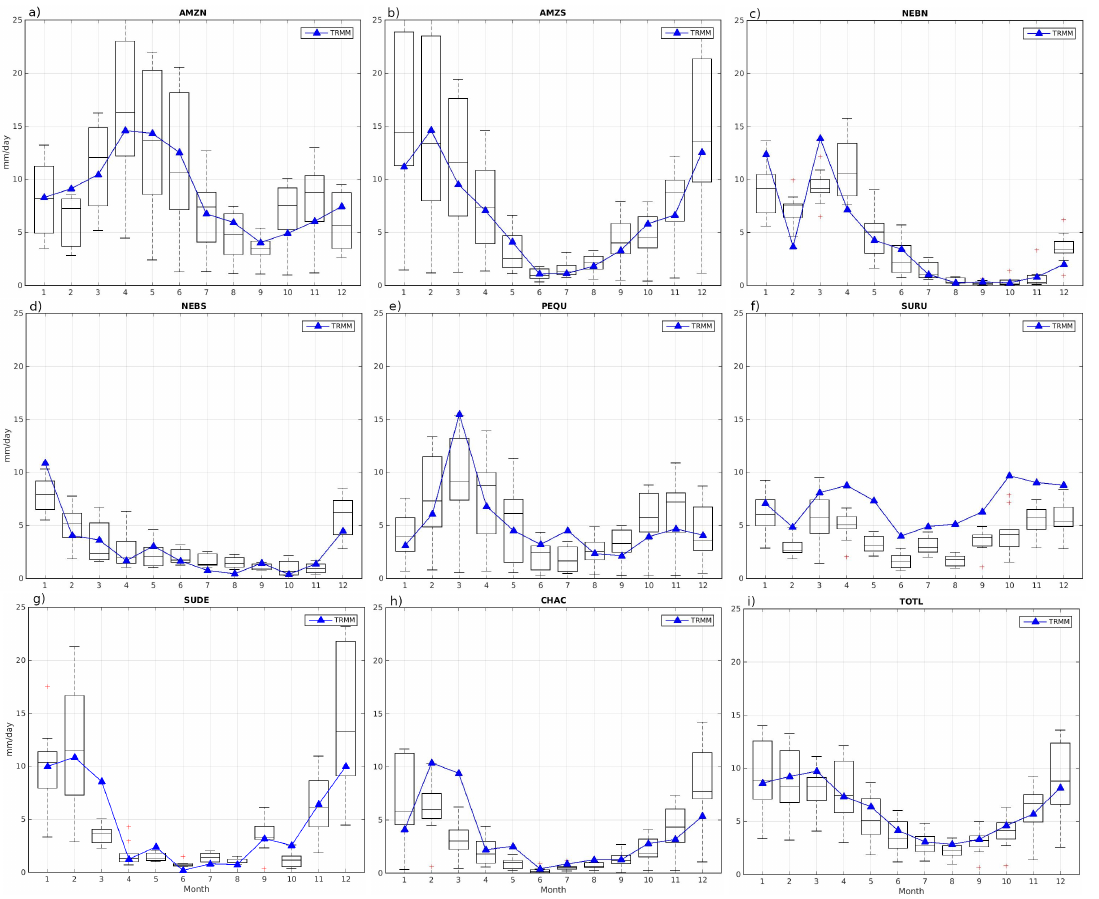
Figure 11. Direct comparison of the annual cycle of simulated ensembles and observations for the eight areas investigated in this study [( a ) AMZN, ( b ) AMZS, ( c ) NEBN, ( d ) NEBS, ( e ) PEQU, ( f ) SURU, ( g ) SUDE, ( h ) CHAC], plus the average over all areas [( i ) TOTL]. Box plots represent the statistical spread of monthly precipitation for all nine members + CTRL. Here, they follow the standard format of box plots, i.e., boxes represent 1st/2nd/3rd quartiles, and whiskers are of 1.5 interquartile range, far from the box limits. Red crosses represent outliers outside this range. The blue line corresponds to TRMM